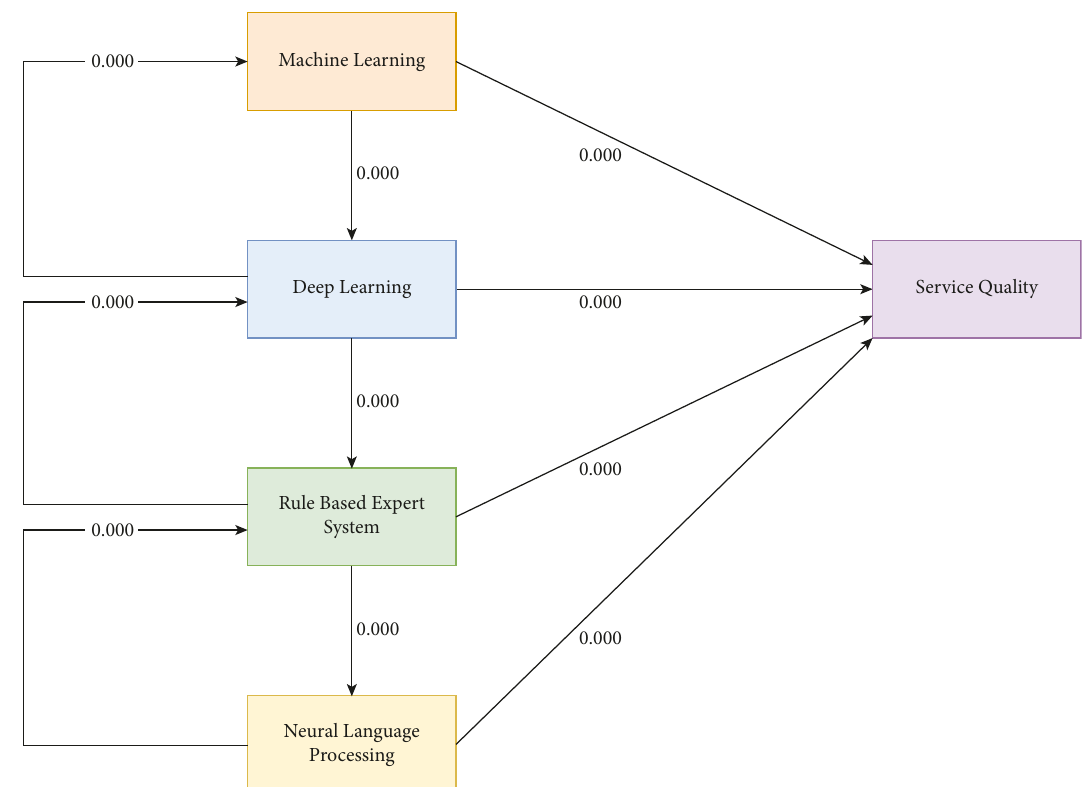
Figure 9: Structural equation model